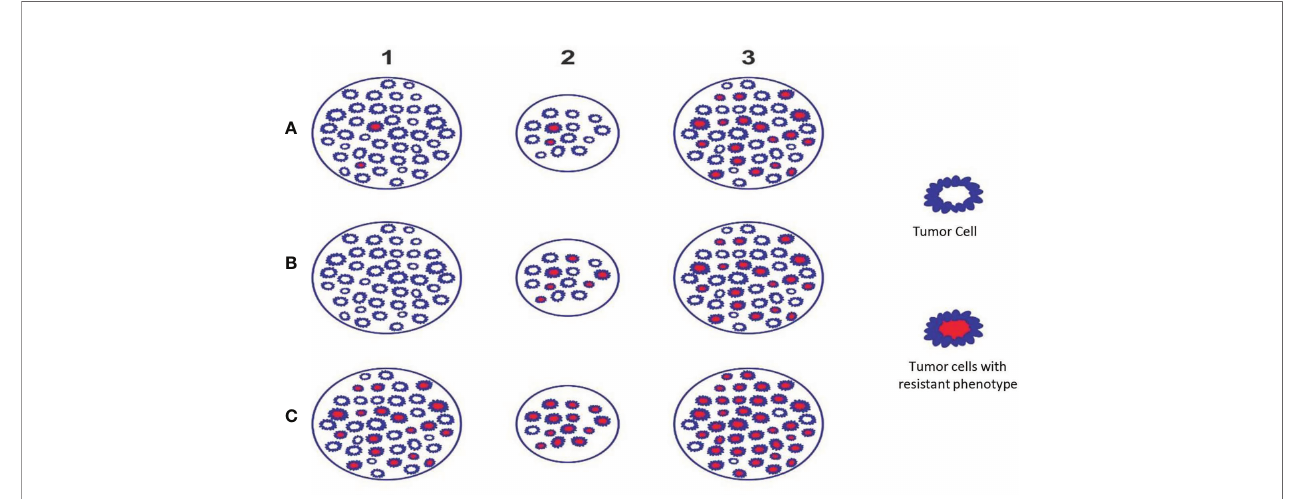
FIGURE 2 | Theoretical Model D - The fi gure depicts the phenotypic pro fi le and criticality of appropriate timing of SBRT. Example A: Initially few resistant phenotypes (A1) which survive during accelerated repopulation from day 21 to 30 of start of treatment or as residual lesion/oligo-persistence (A2) and these cells proliferate subsequently (A3) . Example B: Initially no resistant phenotypes (B1) ; appear during accelerated repopulation from day 21 to 30 of start of treatment or as residual lesion/oligo-persistence (B2) and these cells proliferate subsequently (B3) . Example C: Initially large number of resistant phenotypes is present (C1) ; survive during accelerated repopulation from day 21 to 30 of start of treatment or residual lesion/oligo-persistence (C2) and these cells proliferate to recur or metastasize (C3) . Situations A & B (receptor positive and differentiated tumors) indicates that SBRT can be reserved as “ concomitant ” or delayed boost. Situation C (e.g., receptor negative & aggressivetumors) indicates that SBRT to be considered upfront along with chemo/targeted/immuno-therapy followed by “ concomitant ” and/or “ delayed ” boosts subsequently ( preclinical trials required to establish the validity